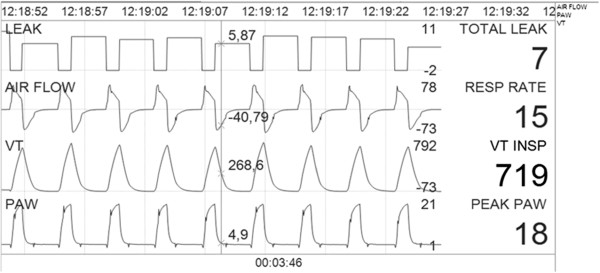
Display of the flow-time, pressure–time, volume-time graphs and unintentional leaks by the BC software in the model with expiratory leakage after correction of the flow-time graph for the intentional (by means of a leak test) and unintentional leaks (following the method of retrograde comparison of areas).